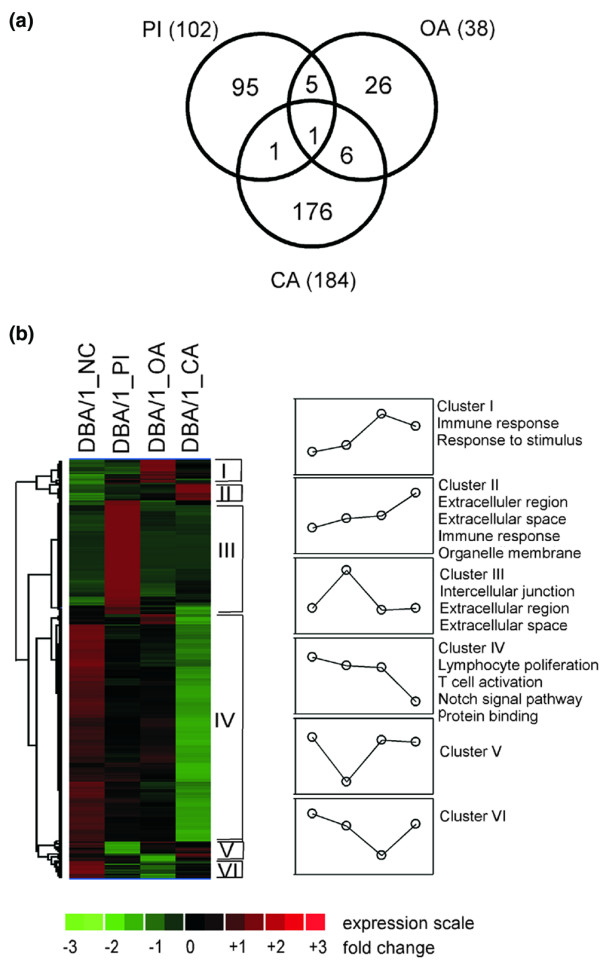
Differentially expressed genes in the DBA/1 strain during collagen-induced arthritis (CIA). Three experimental conditions, post-immunisation (PI), onset of arthritis (OA) and chronic arthritis (CA), were compared with naïve control (NC) to search for differentially expressed genes. (a) Venn diagram indicating the number of overlapping genes differentially expressed at three phases of CIA. (b) Hierarchical clustering of the 310 differentially expressed genes. The left panel shows the distribution of relative gene expression across the hierarchical tree structure. Rows represent individual genes; columns represent individual value of triplicate samples for each experimental group. Each cell in the matrix represents the expression level of a gene, with red and green indicating transcription levels above and below the normal values for that gene, respectively. Four sample groups are indicated above the expression matrix. Six basic gene clusters (clusters I to VI) were yielded by the analysis according to the gene expression pattern during CIA. The expression patterns of the gene cluster are graphed and the major biological activities for each cluster that were examined by functional clustering analysis are indicated on the right.